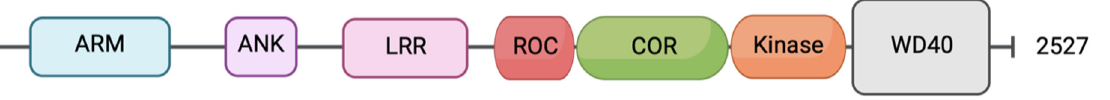
Figure 1. Simple schematic of LRRK2 protein structure (2527 amino acids long) and its domains. ROC, COR, and kinase make up the enzymatic domains of LRRK2, whereas ARM, ANK, LRR, and WD40 control protein–protein interactions. Created with BioRender.com (accessed on 25 July 2022).